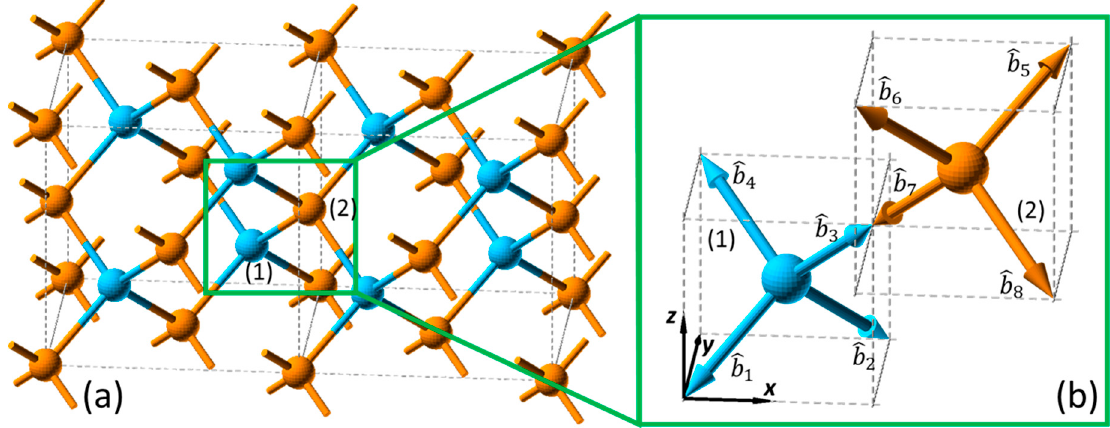
Figure 2. ( a ) Bond and ( b ) bond vector structure of Si(100) in the SBHM. Meanwhile, with the central atom at Position (2), another four bond vectors can be found at the right opposite directions, such that